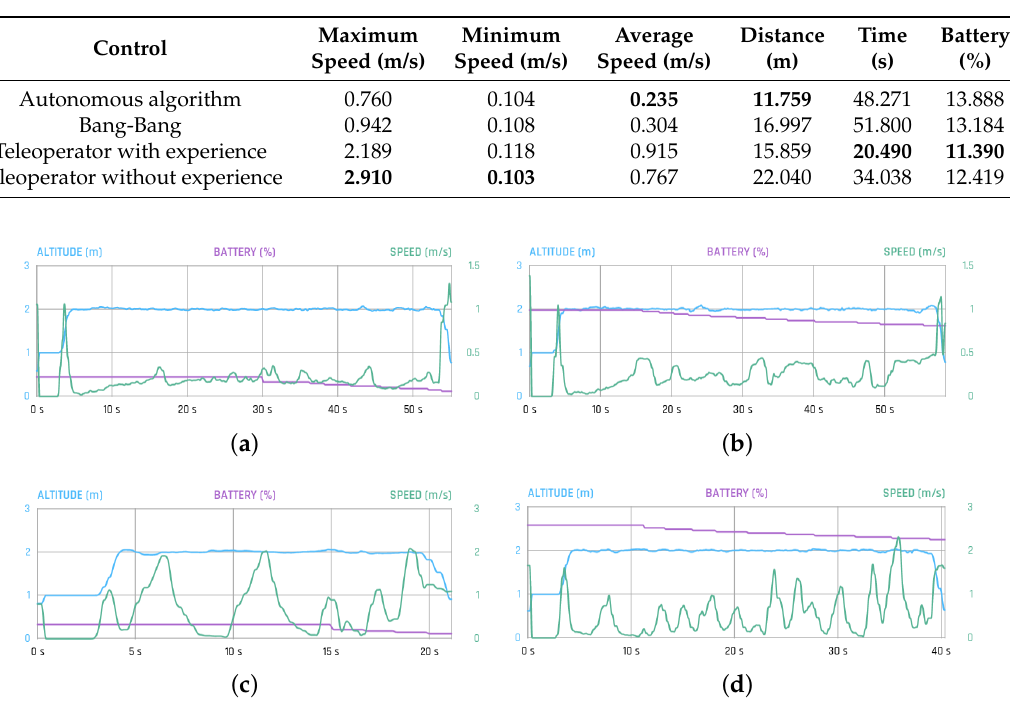
Table 4. One fixed obstacle and two mobile obstacles.